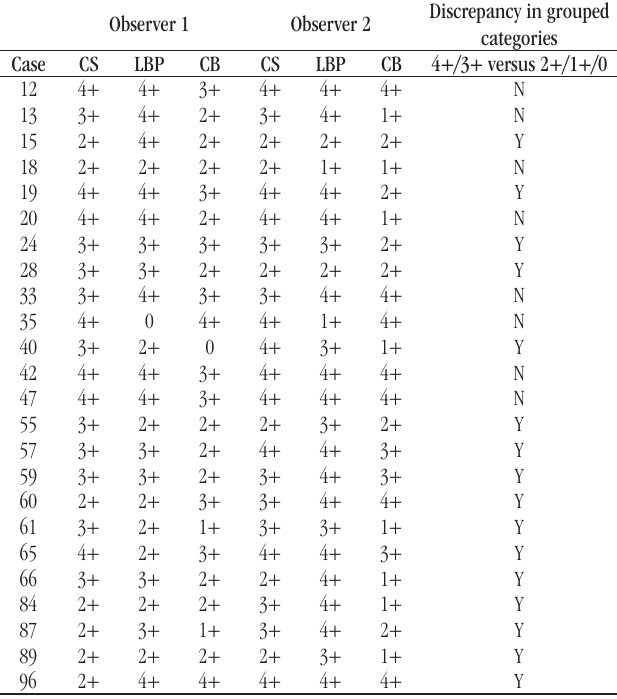
taBLE − Cases with interpretation discrepancy between observers in evaluation of 106 FNAB cases of thyroid nodules in diagnostic routine, including CS, LBP, and CB Discrepancy in grouped Observer 1 Observer 2 categories